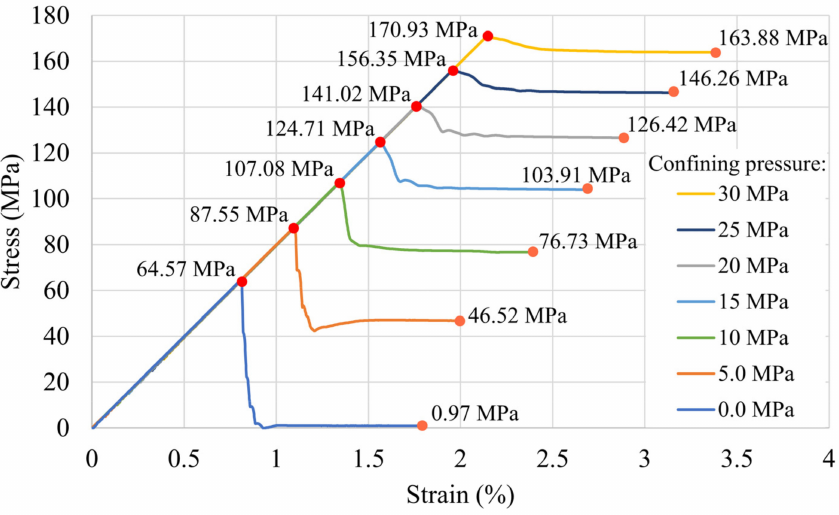
Figure 1. Stress-strain curves of the simulated rock material under different confining